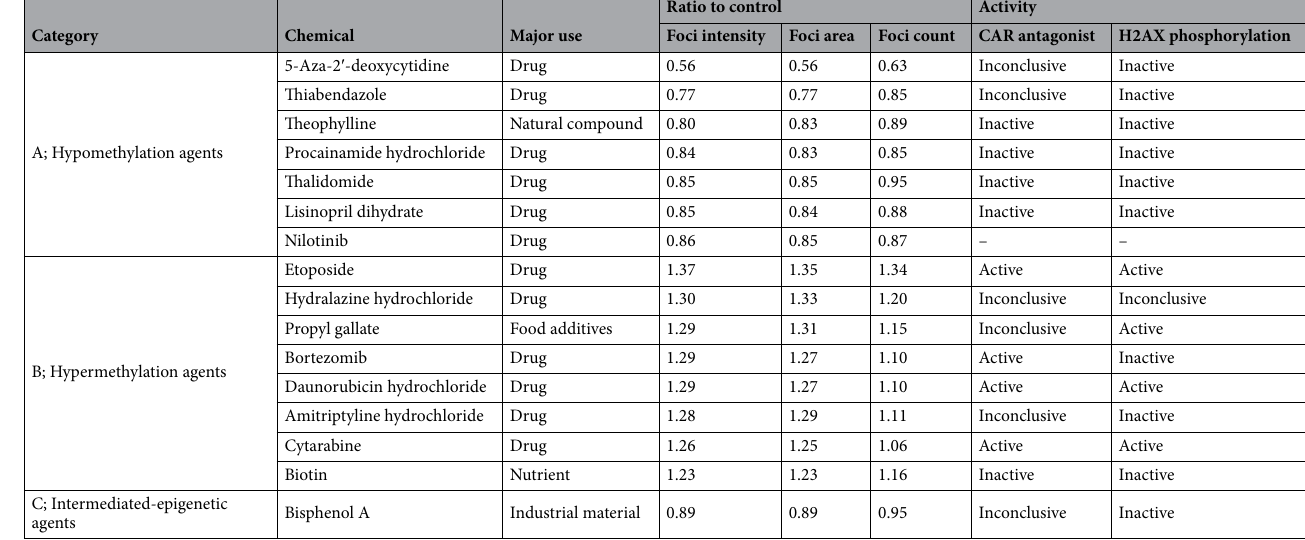
Table 1. Effects of hypomethylation, hypermethylation, and intermediated epigenetic agents on fluorescent MBD foci parameters and physiological activities. – Data were not